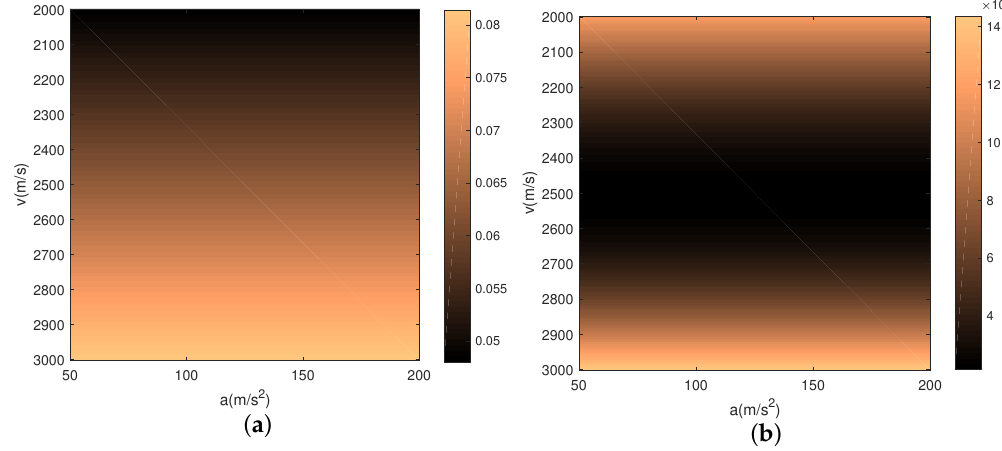
Figure 5. The ISL of the sequences designed by the WeCAN algorithm and the IAG algorithm under different motion states. ( a ) WeCAN; ( b )